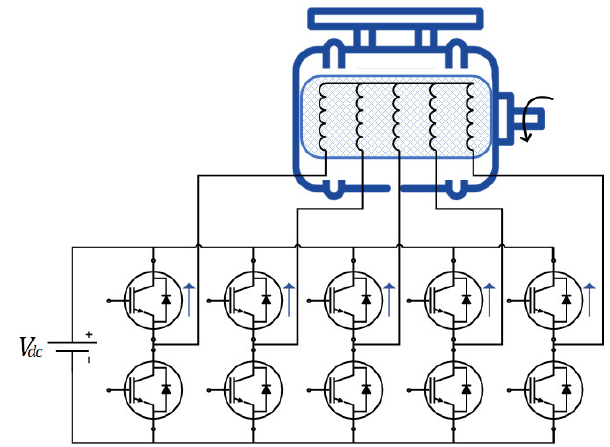
Figure 8. Two-level converter topology for a five-phase voltage source drive.